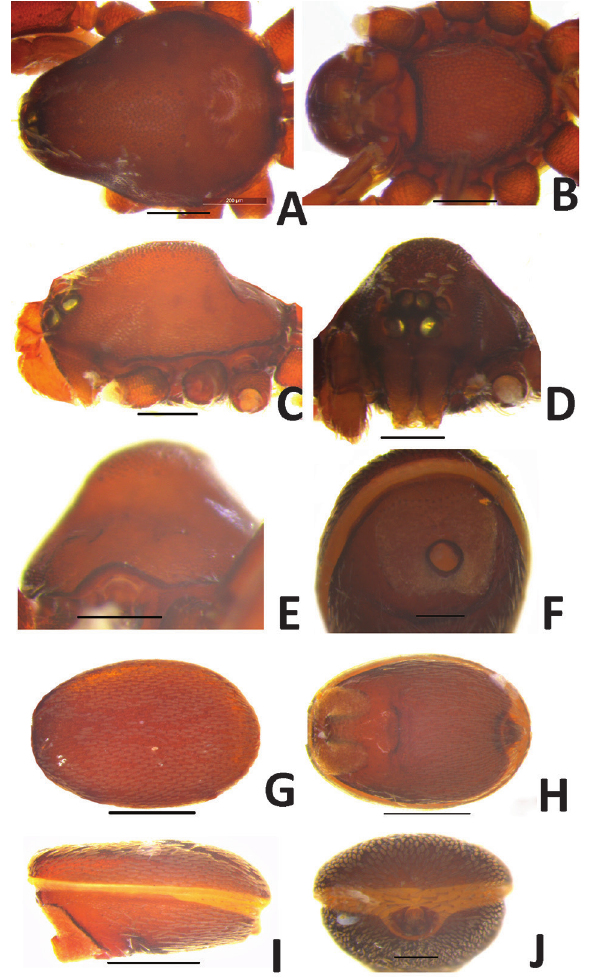
Figure 3. Grymeus dharmapriyai n. sp., male from Wana- thavilluwa: A , carapace, dorsal view; B , sternum, ventral view; C , carapace, lateral view; D , same, anterior view; E, same, pos- terior view; F , abdomen, anterior view; G , same, dorsal view; H , same, ventral view; I , same, lateral view; J , same, posterior view. Scale bars: 0.2 mm ( A–F, J ), 0.5 mm ( G–I ).